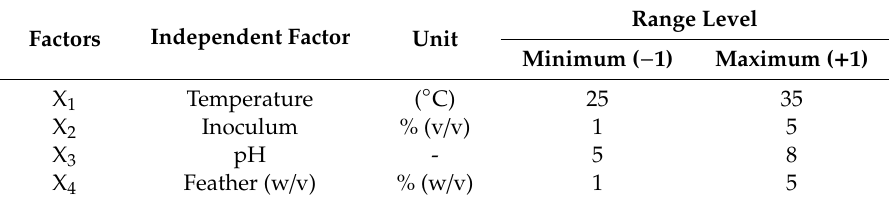
Table 8. Experimental factors and level of minimum and maximum range for statistical screening using Plackett-Burman factorial design